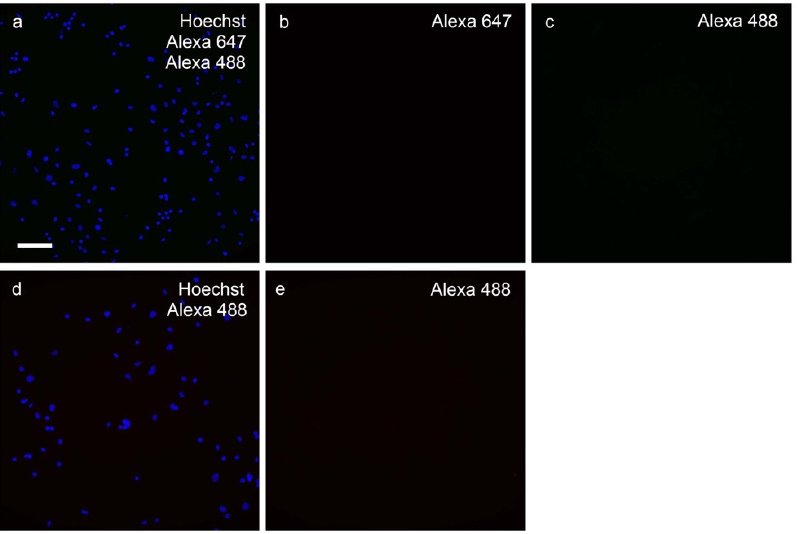
Figure 11. The omission of the primary antibodies resulted in complete absence of the immunoreac- tivity. Primary hippocampal neuronal cultures were labeled with ( a ) Hoechst 33,342 (blue); ( b ) goat anti-mouse Alexa 647 (red); ( c ) goat anti-guinea pig Alexa 488 (green); ( d ) Hoechst 33,342 (blue); and ( e ) goat anti-rabbit Alexa 488 (green). Scale bar = 100 µ